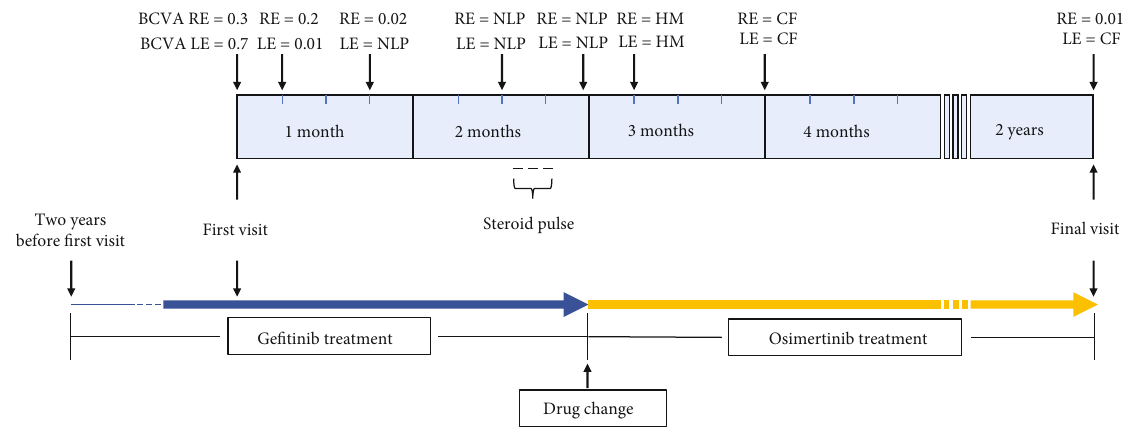
Figure 6: Visual acuity and treatment timeline. Decimal best-corrected visual acuity (BCVA) is described from the fi rst visit to the fi nal visit. RE: right eye; LE: left eye; CF: counting fi ngers; HM: hand motion; NLP: no light perception. Ge fi tinib is changed to osimertinib two months after the fi rst visit. Three courses of steroid pulse treatment are administered before changing to